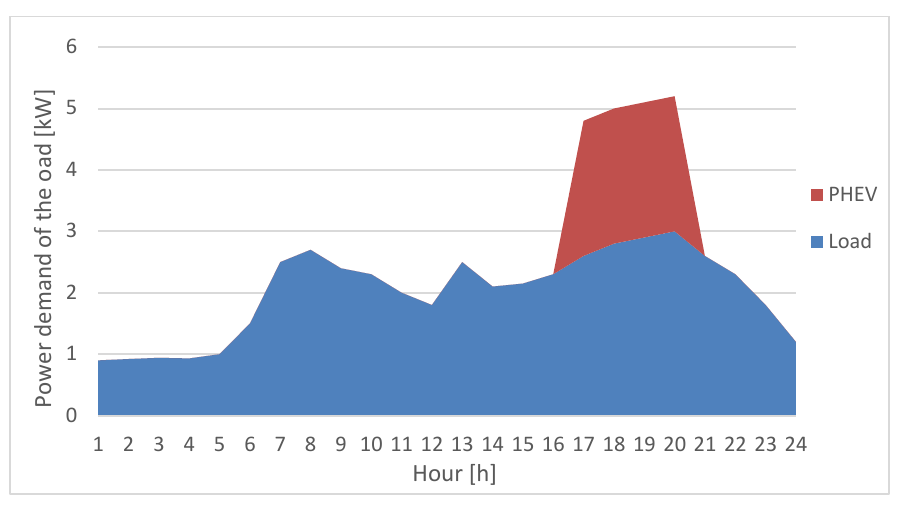
Figure 1. Power demand of the load (household appliances) and PHEV (case A).